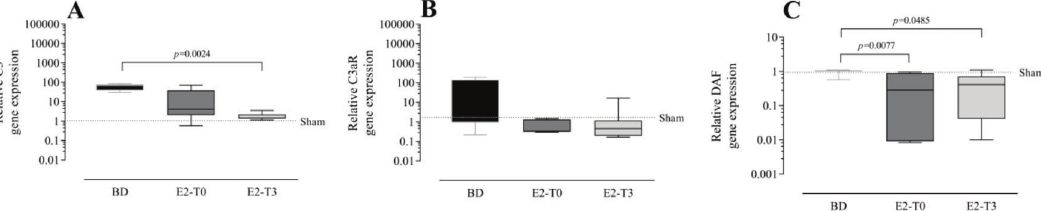
Figure 3 - Lung gene expression of complement system components C3 (A), C3aR (B) and decay-accelerating factor (DAF) (C). Female rats were separated in groups: sham animals as control, BD animals subjected to brain death (BD), E2-T0 animals subjected to BD and treated with 17 b -estradiol (E2) starting after BD confirmation, and E2-T3 animals subjected to BD and treated with E2 3h after BD confirmation. Data are expressed as median and 95% percentile interval from 6 animals. Kruskal-Wallis p =0.0015 (A), p =0.1715 (B) and p =0.005